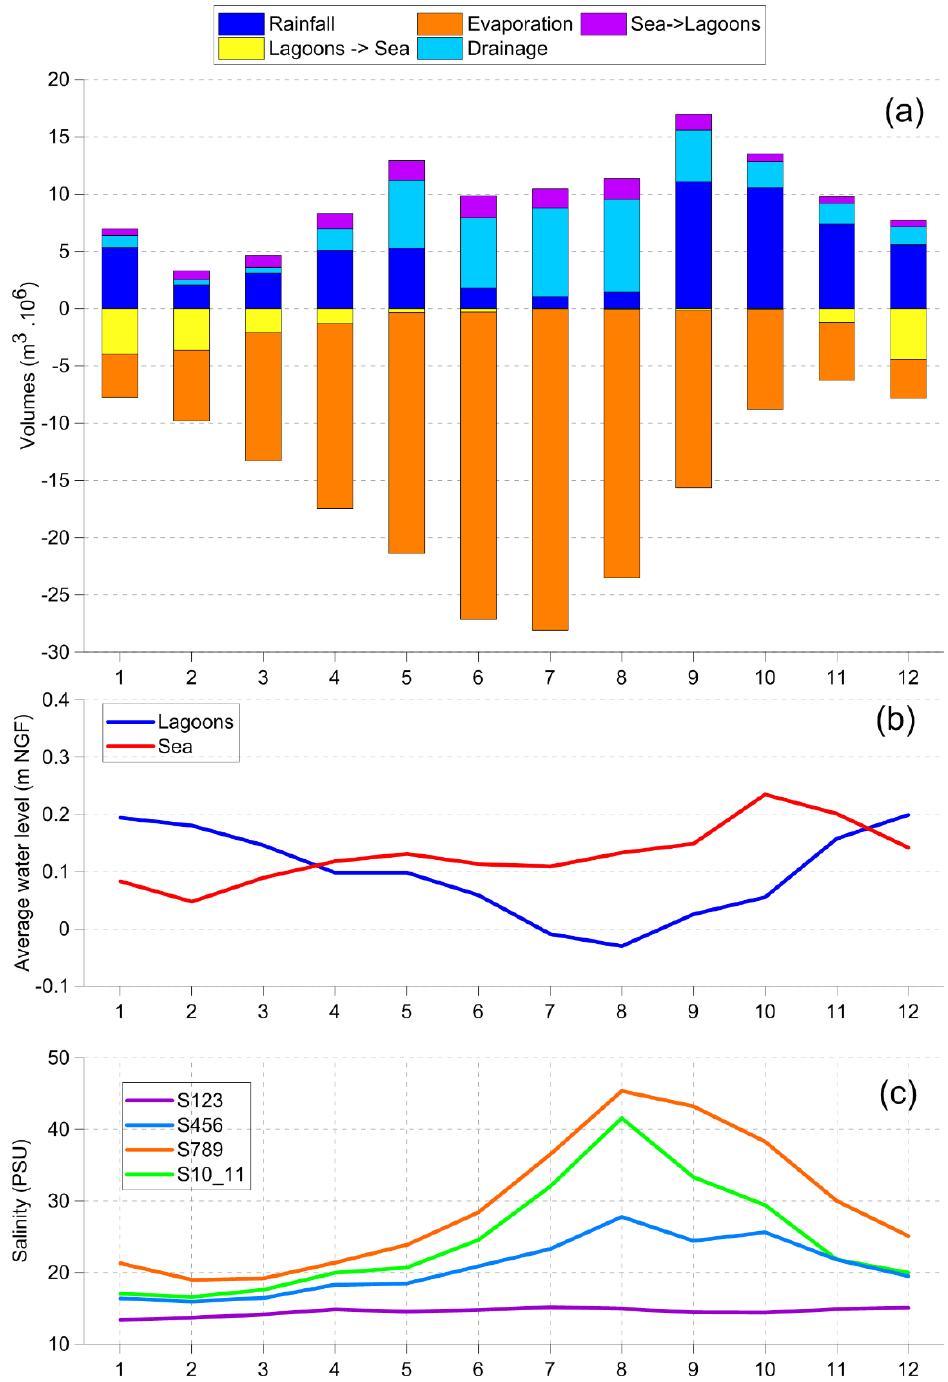
Figure 10. ( a ) Average total volumes exchanged during each month between the Vaccarès Lagoon System and (i) the Sea, at the Fourcade connection (“Lagoons- > Sea” and “Sea- > Lagoons”); (ii) the atmosphere (“Evaporation” and “Precipitations”); and (iii) the agricultural watershed of the Fumemorte (“Drainage”). Averages calculated over the 1999–2007 period, during which all data sources were available. ( b ) Average water level in the Vaccarès Lagoon System (average value of the water levels measured at the locations 12, 14, and 15). Average Sea level is also shown (measured at location 13). ( c ) Average monthly salinities for the period 1999–2007. Purple: average salinities from locations 1, 2, and 3 (Figure 2). Blue: average salinities from locations 4, 5, and 6. Red: average salinities from location 7, 8, and 9. Green: average salinities from locations 10 and 11. Months are represented on the X-axis (1: January; 12: December).